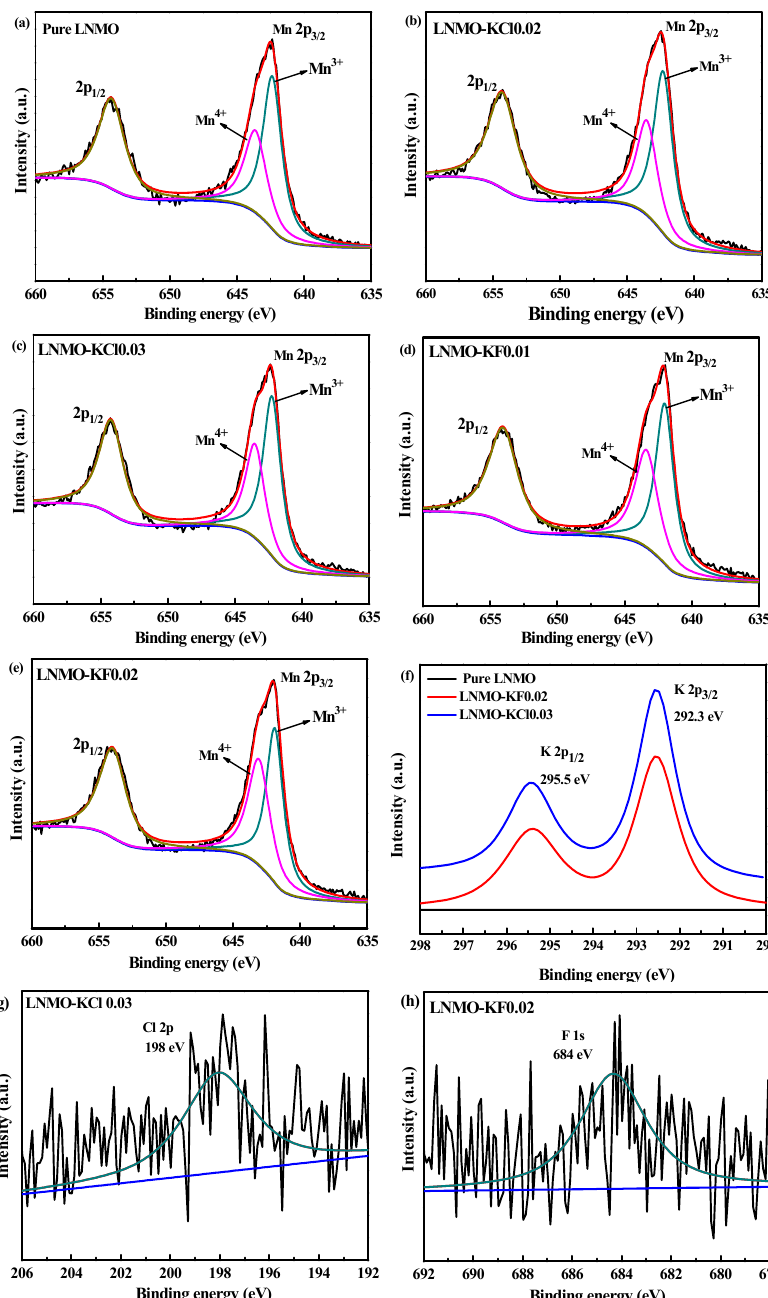
Figure 3. XPS spectra of Mn 2p regions for pure LNMO ( a ), LNMO-KCl0.02 ( b ), LNMO-KCl0.03 ( c ), LNMO-KF0.01 ( d ), and LNMO-KF0.02 ( e ); XPS spectra of K 2p for LNMO-KCl0.03 and LNMO-KF0.02 ( f ); XPS spectrum of Cl 2p for LNMO-KCl0.03 ( g ); XPS spectrum of F 1s for LNMO-KF0.02 ( h ).